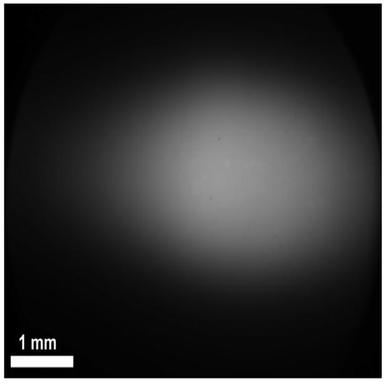
PL image of the 18 MeV proton beam transversal intensity distribution stored in a 1 mm-thick LiF crystal at an average dose of 1.8 × 104 Gy.